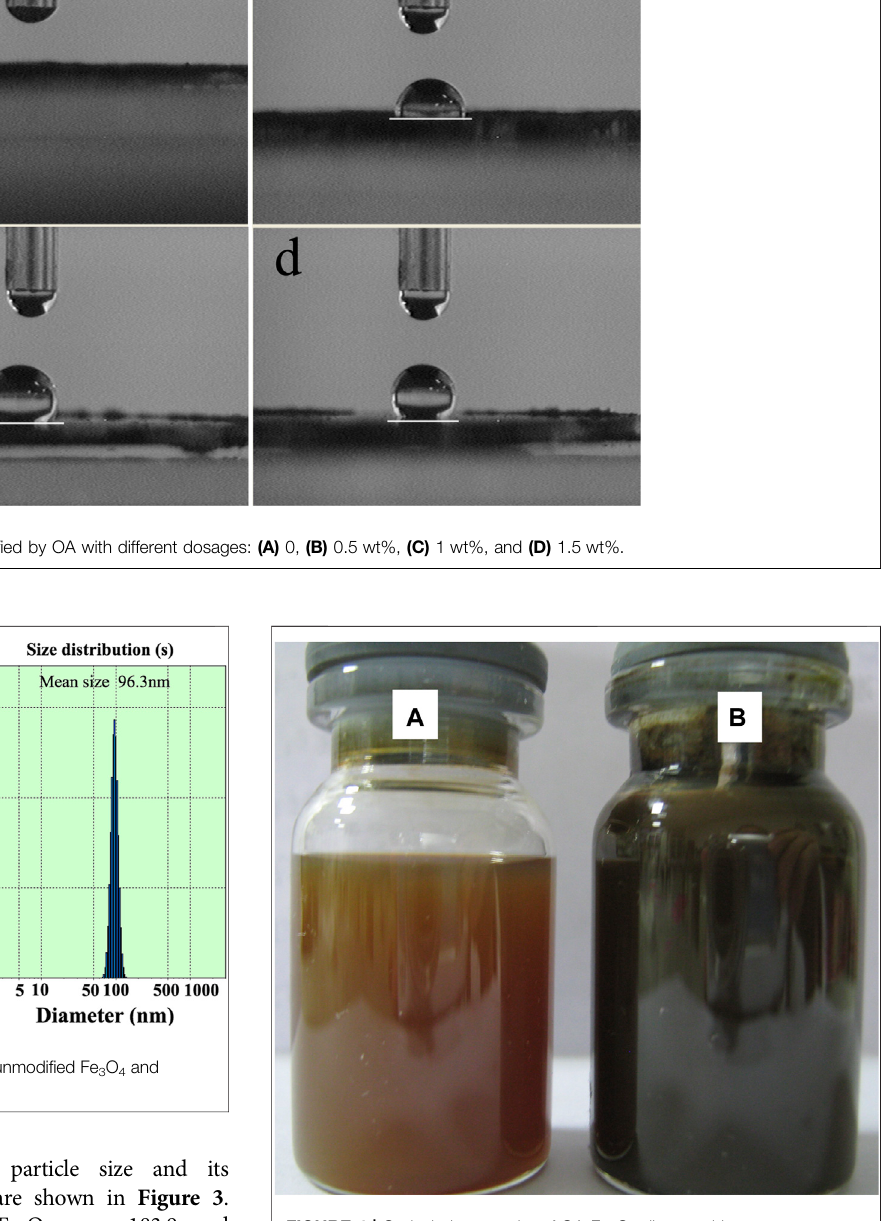
FIGURE 4 | Optical photography of OA-Fe 3 O 4 dispersed in styrene monomer with different contents: (A) 0.8 wt% and (B) 1.6